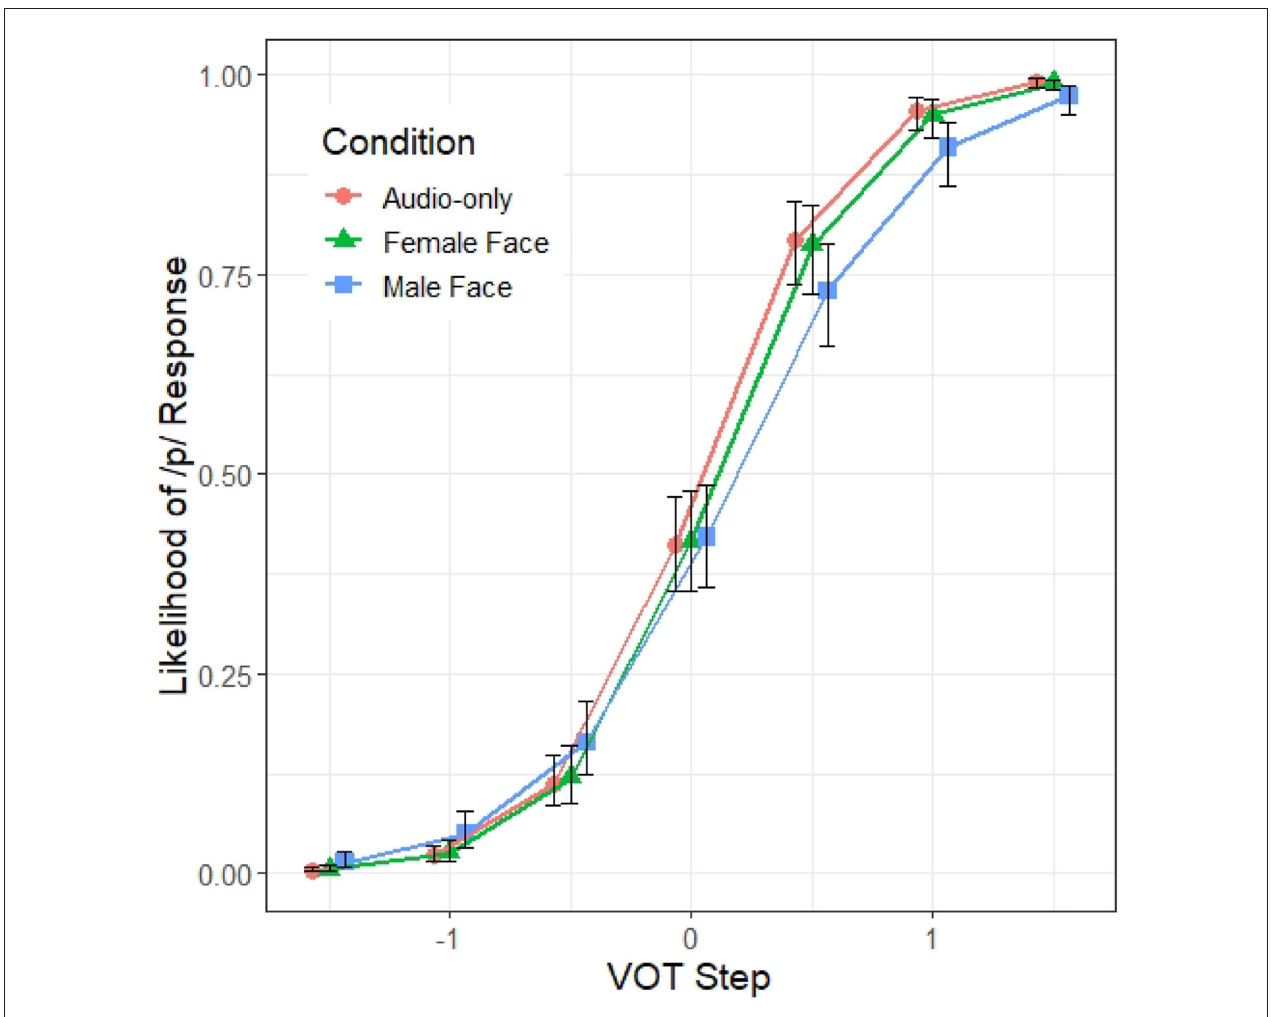
FIGURE 3 | Model 1 predictions of the probability of a /p/ response (y axis) at different steps along the VOT continuum (x axis) and across the three prompt conditions. The error bars indicate 95% confidence